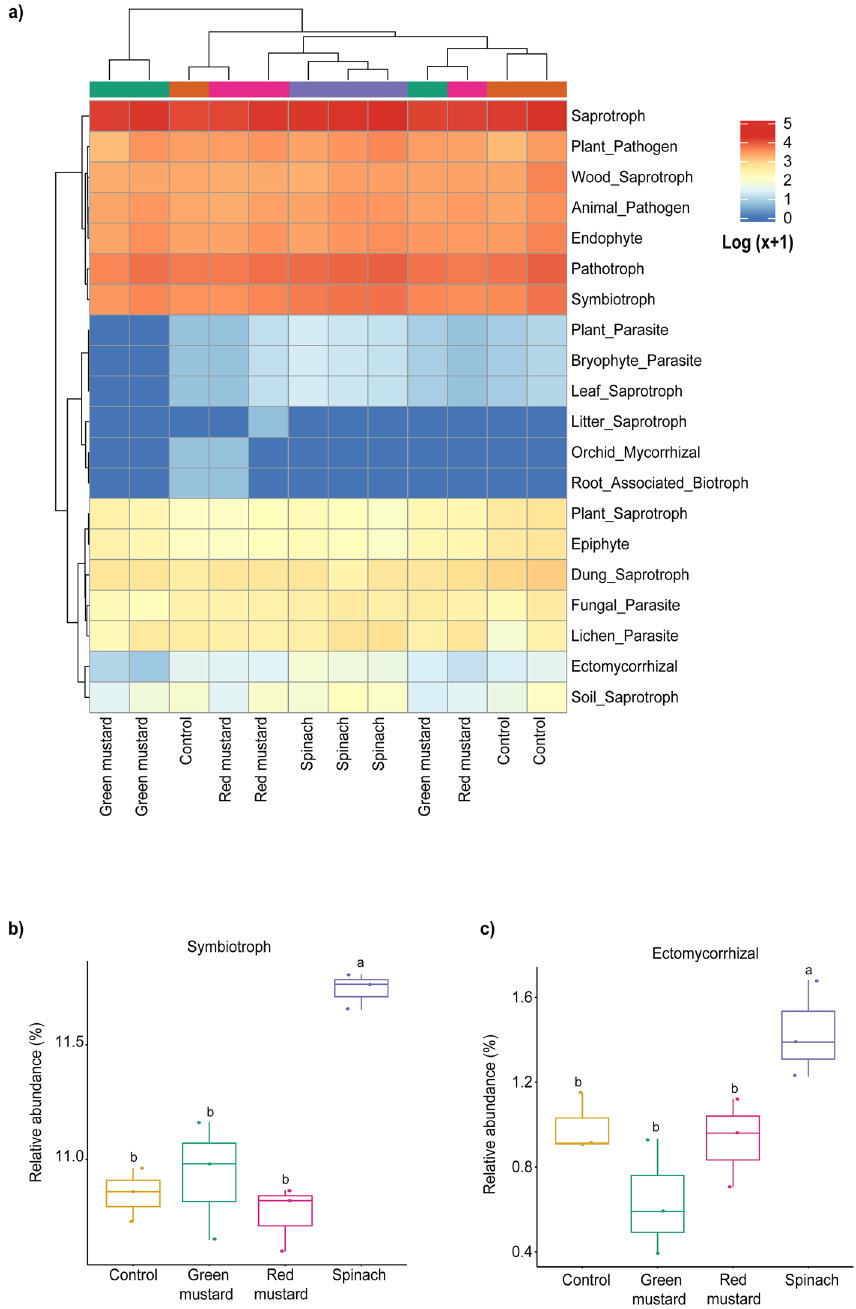
Figure 5. Predicted ecological functions of soil fungal communities in different green manure-amended soils. Heatmap depicting the predicted ecological functions of soil fungal communities in different green manures based on the FUNGuild database ( a ). Spinach-amended soil enriched with symbiotroph ( b ) and ectomycorrhizal ( c ) predicted functions when compared to other green manures and